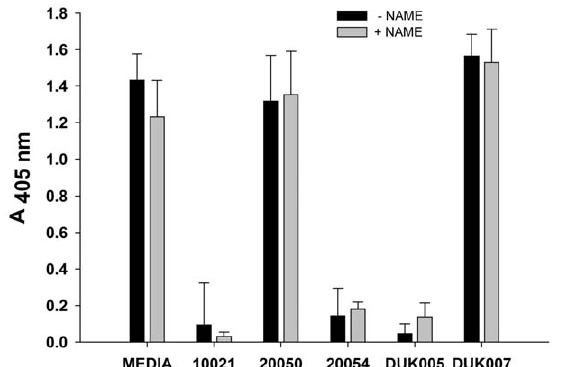
Figure 12. Pretreatment with L-NAME does not affect peptide inhibition of apoptosis. HUVEC were grown to 70–80% confluence in a 96-well tissue culture plate. Media was removed from the wells and to each of quadruplicate wells was added 200 m l of either fresh media (untreated) or fresh media containing 2 mM L-NAME and the cells incubated 5 h at 37 u C. To each well was then added the indicated peptide to achieve a concentration of 50 m M and the cells incubated an additional 3 h at 37 u C before addition of staurosporine to a final concentration of 500 nM. The plate was incubated ON at 37 u C and the cells processed for measurement of apoptosis using the Cell Death Detection Assay (Roche Diagnostics) per the manufacturer’s instruc- tions.